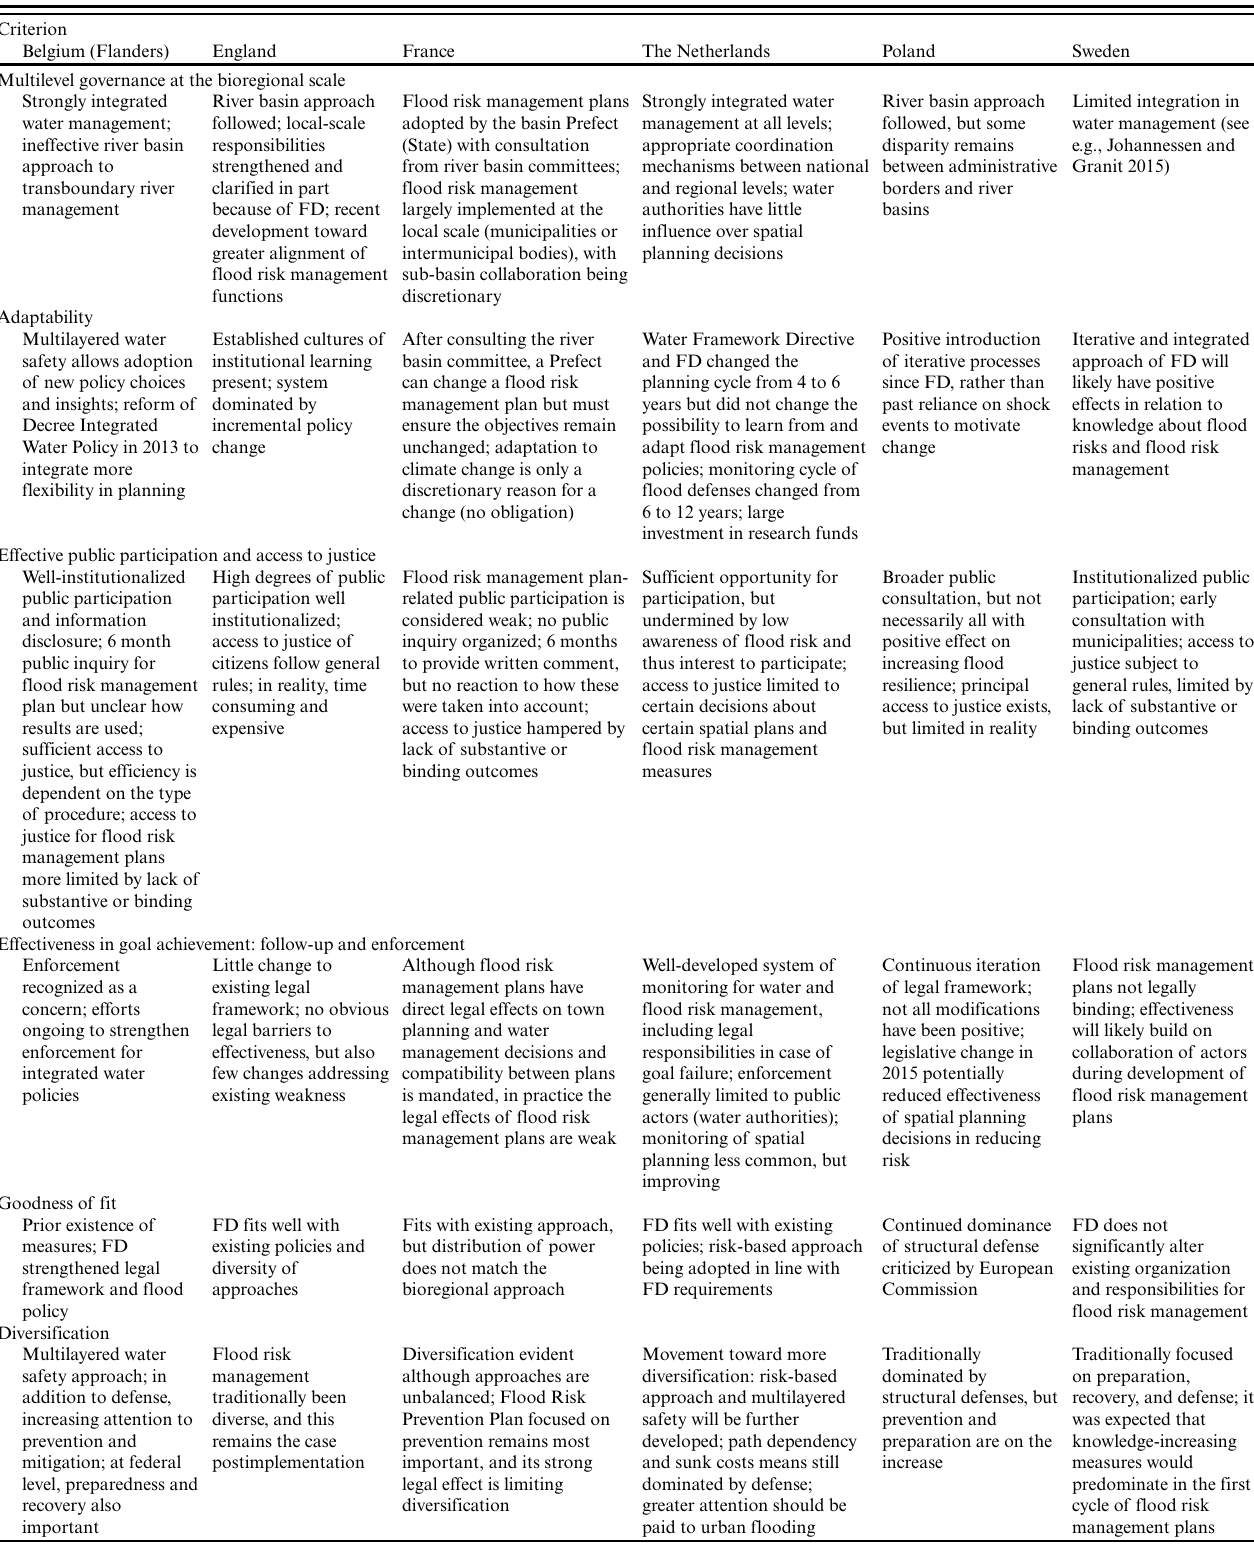
Table 4. Evaluation of the national implementation of the Floods Directive (FD) in six European countries. Criterion Belgium